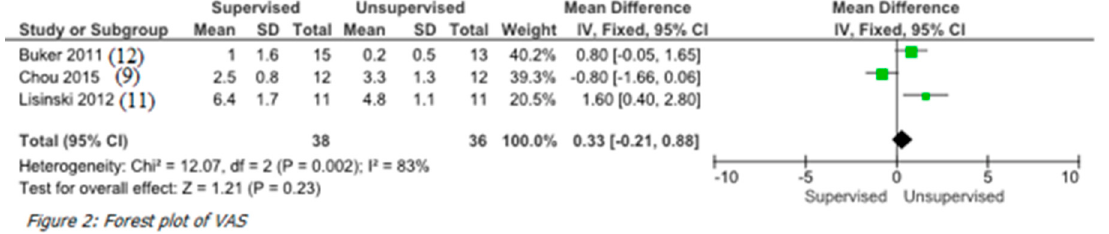
Figure 2. Forest plot of VAS score.